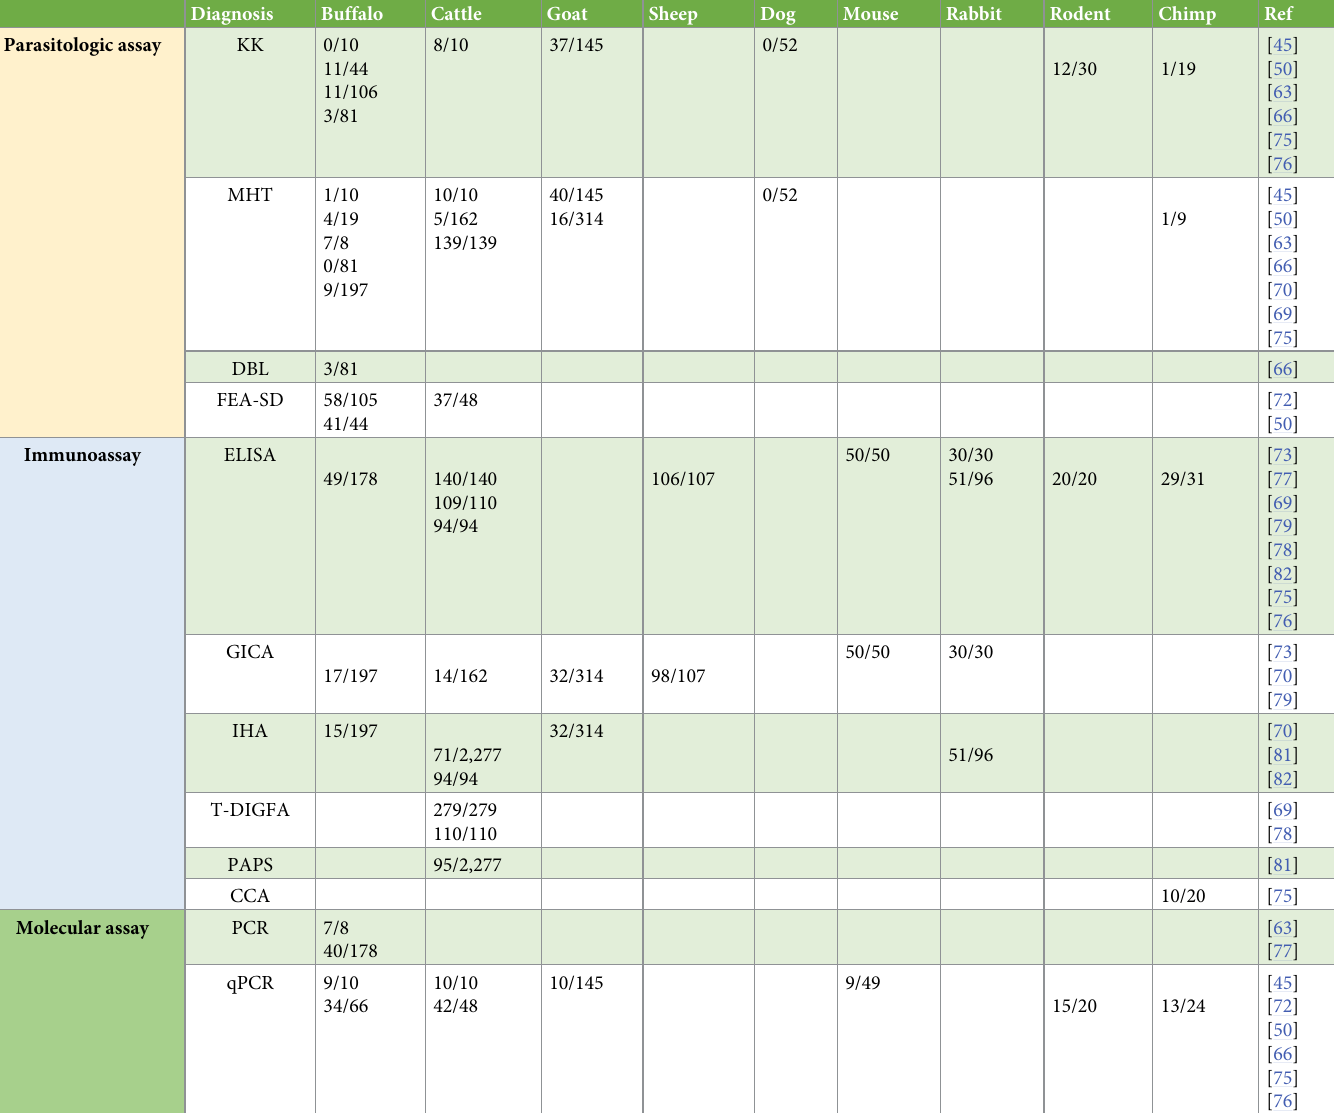
Table 2. Result of different diagnostic techniques used in the included studies (number of test positive/numbers of